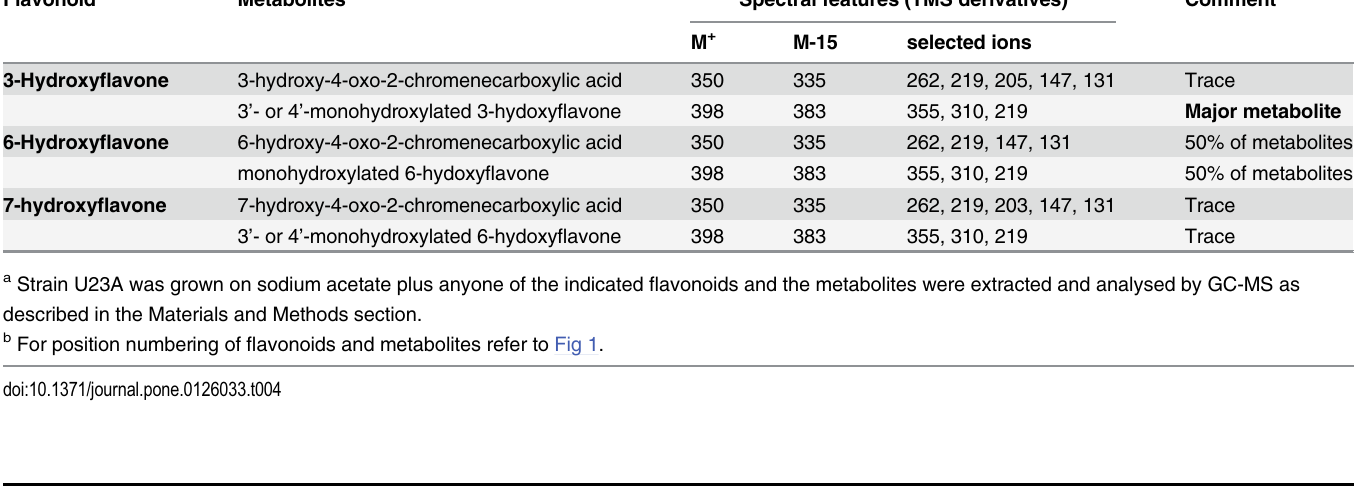
Table 4. Metabolites produced by strain U23A during co-metabolic growth on mono-hydroxyflavones. Flavonoid b Metabolites a, b Spectral features (TMS derivatives) Comment M + M-15 selected ions